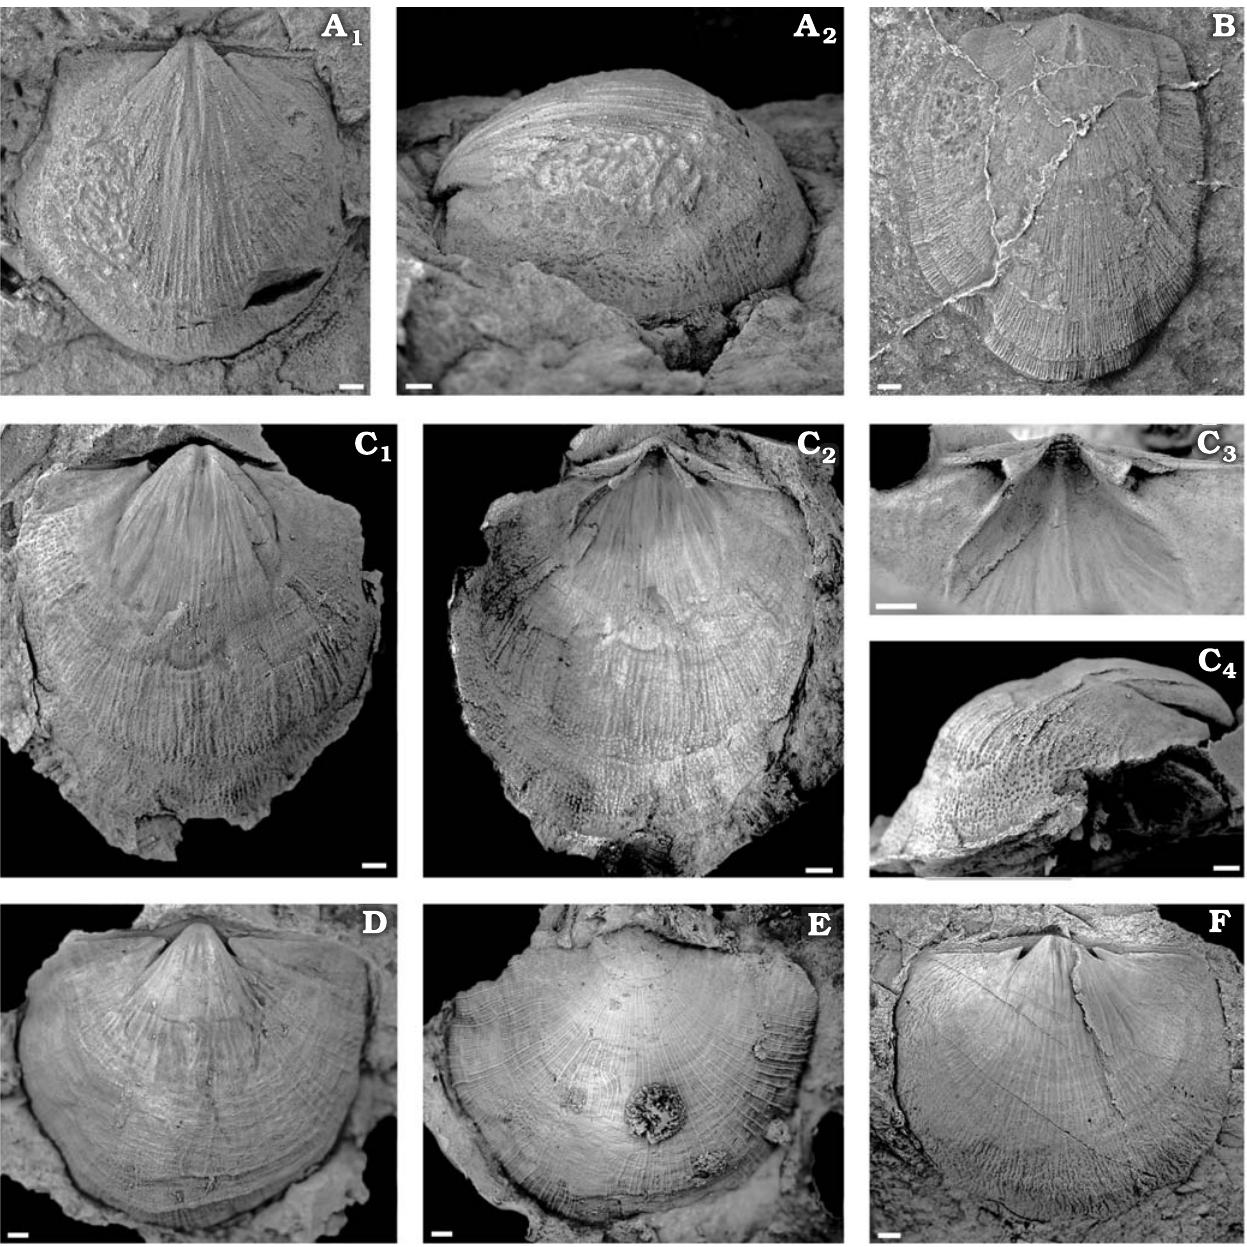
Fig. 15. Ventral valves of rafinesquinine brachiopod Rafinesquina ( Mesogeina ) pomoides Havlí č ek, 1971; middle Katian (Ka2), Upper Ordovician; Lower Ktaoua Formation (A) and Upper Tiouririne Formation (B), Morocco; Huerva Member of Fombuena Formation, Iberian Chains, Spain (C); Porto de Santa Anna Formation, Portuguese Central Iberian Zone, Portugal (D–F). A . MPZ_2003_832, ventral internal mould of a complete valve in upper (A 1 ) and lateroblique (A 2 ) views. B . MPZ 2015/1390, latex cast of ventral exterior of a ventral valve. C . DPZ-318 (ex-holotype of Rafinesquina lignani Villas, 1985), ventral internal mould (C 1 ), latex cast of ventral interior (C 2 ), detail of dental plates (C 3 ), and lateral view (C 4 ). D . IGM-2545A, ventral internal mould. E . IGM-2545B, latex cast of exterior. F . IGM-2945, internal mould. Scale bars 2